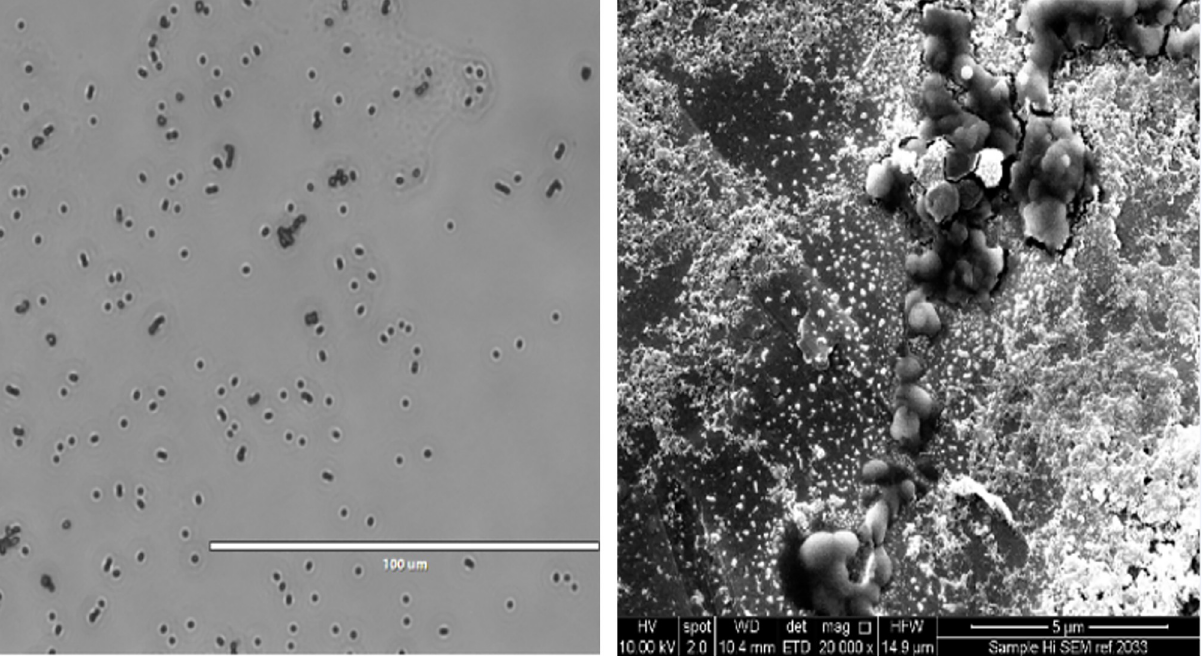
PLOS ONE | https://doi.org/10.1371/journal.pone.0278277 March 3,